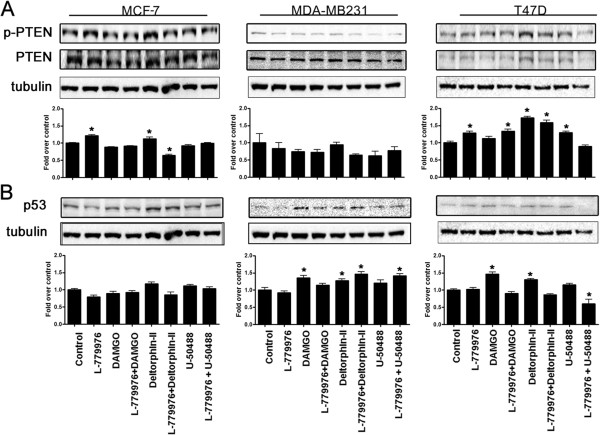
Tumor suppressor proteins PTEN and p53 are modulated in cell and receptor specific manner in tumor cells. Representative immunoblots showing the effect of SSTR2 or ORs activation on the expression of PTEN (A) and p53 (B) in MCF-7, MDA-MB231 and T47D cells respectively. (A) The expression of PTEN is enhanced in MCF-7 as well as T47D cells; however the MDA-MB231 cells displayed no discernible changes in the levels of PTEN. (B) The expression of p53 was in a receptor and cell-specific manner. Note the comparable changes in PTEN and p53 expression in MCF-7 and T47D cells. Histograms illustrate densitometric analysis of PTEN and p53 levels using tubulin as the loading control. The results presented here are representation of mean ± SEM, n = 3. Significant difference was considered at *p < 0.05 vs. control.